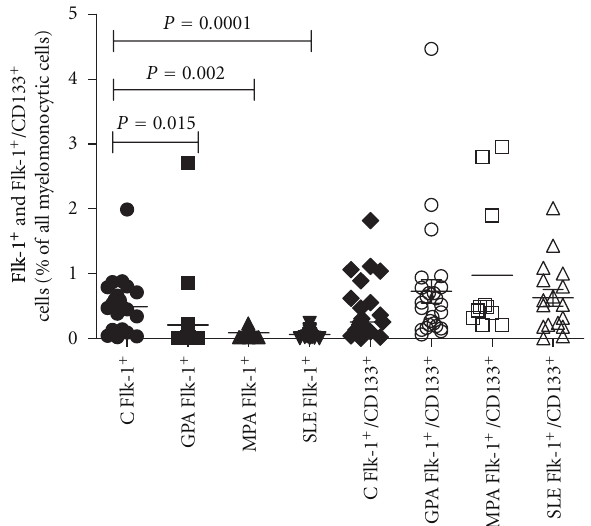
Figure 1: Flk-1 + and Flk-1 + /CD133 + myelomonocytic cells (eEOCs) in patients with GPA, MPA, and SLE as compared to healthy controls. The percentages of circulating Flk-1 + cells (defined as all cells displaying endothelial characteristics) were lower in all patient groups (GPA, MPA, SLE) as compared to healthy controls. In contrast, total peripheral circulating eEOCs (Flk-1 + /CD133 + cells) were not di ff erent between the four groups (bars show median).